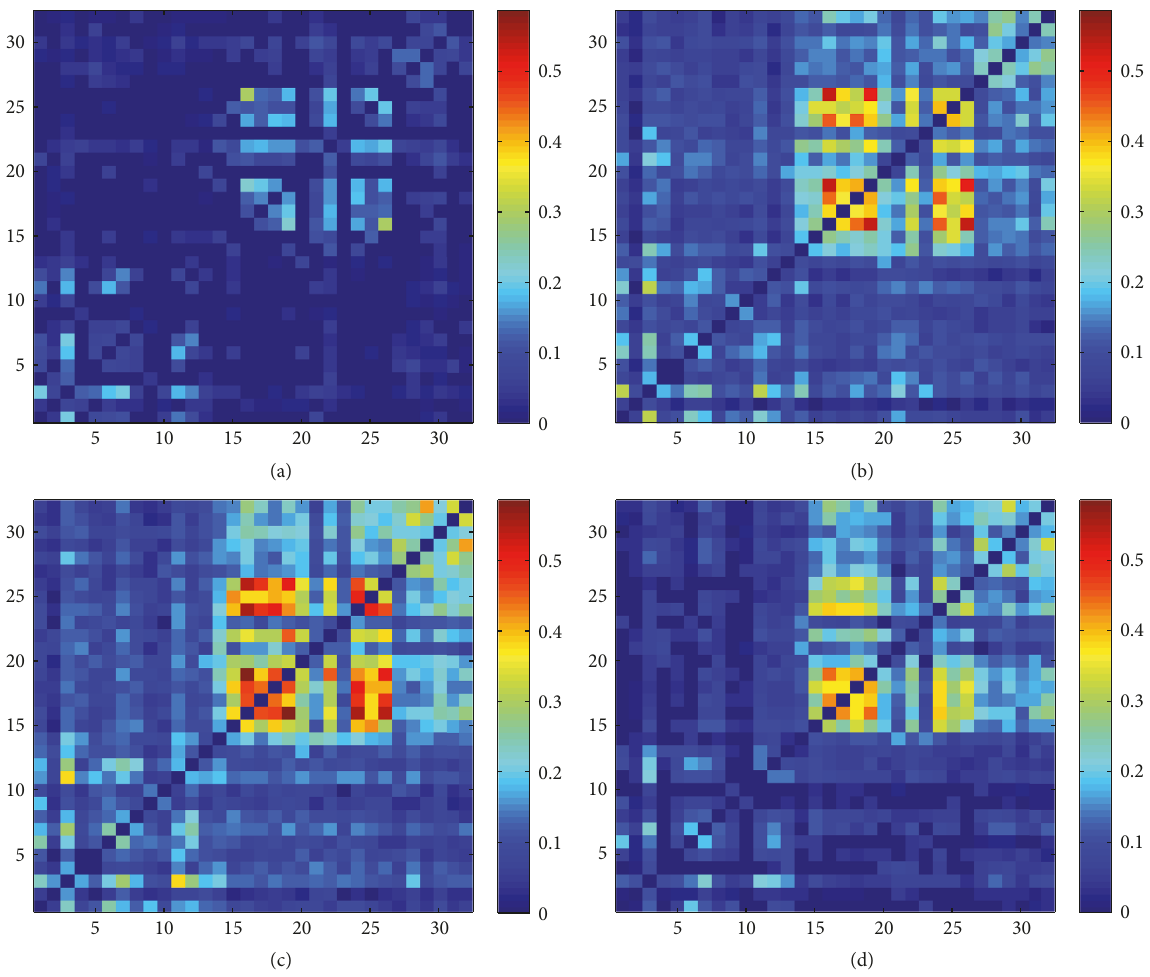
Figure 6: The color maps of the contagion distribution in different windows. (a) The color map for the 5th window. (b) The color map for the 15th window. (c) The color map for the 25th window. (d) The color map for the 35th window.